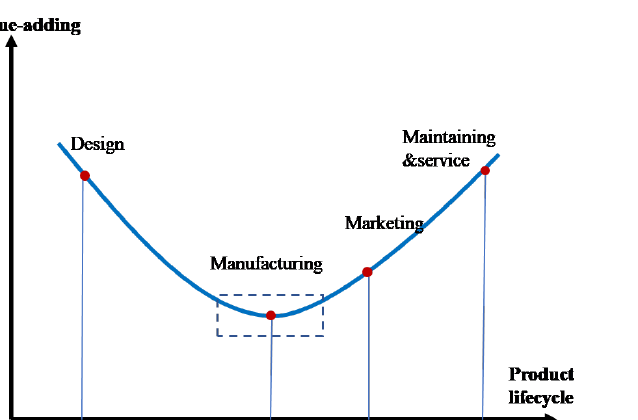
Figure 3. Smiling curve illustrating the relationship between the product life cycle and the benefits on different phases [16]